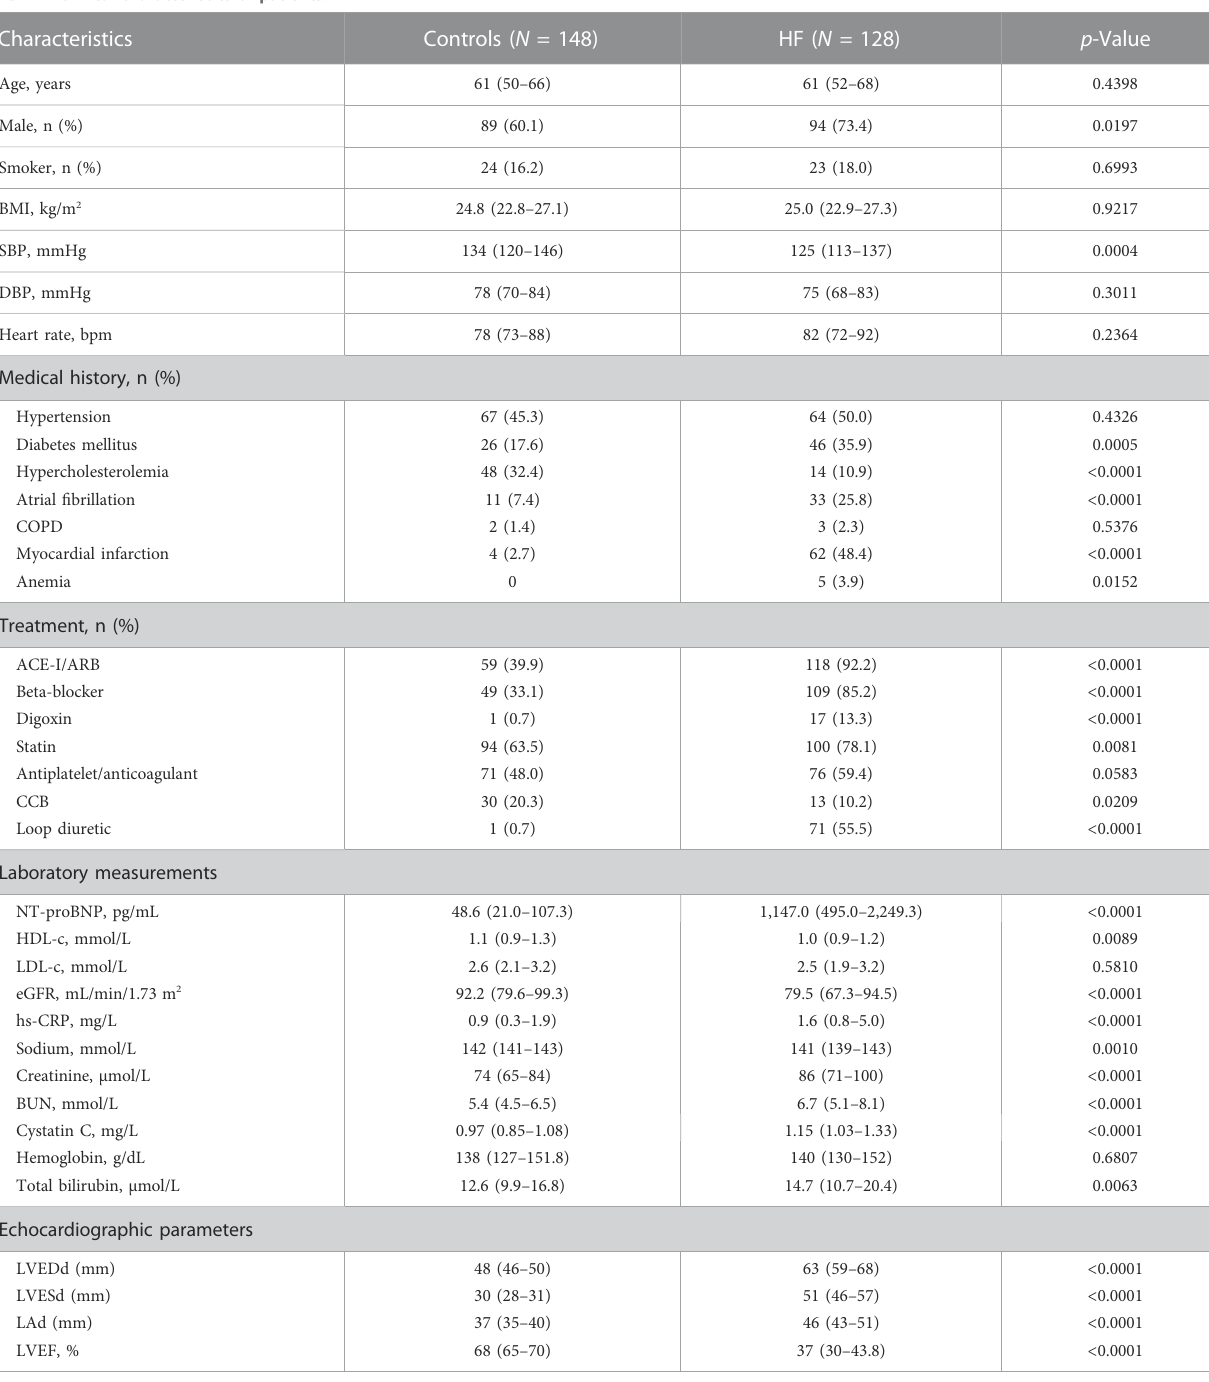
TABLE 1 Clinical characteristics of